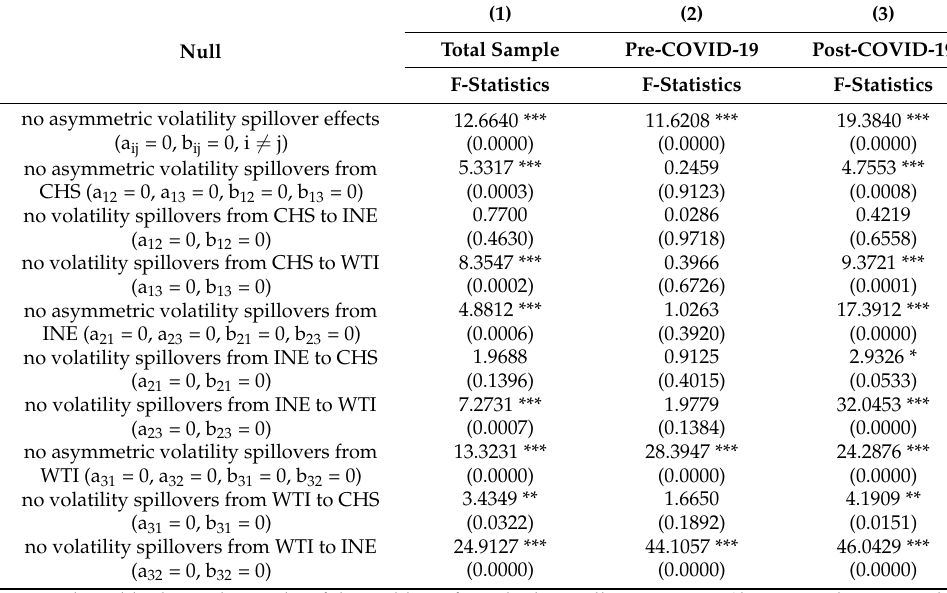
Table 11. Wald test